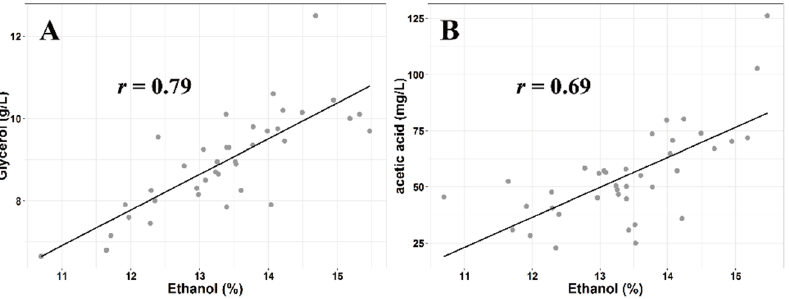
Figure 3. Correlation analysis between ethanol and glycerol ( A ) and acetic acid ( B ). For other fermentation aroma compounds, the Marselan wines from JDP and BHB contained relatively higher concentrations of isoamyl acetate, hexyl acetate, phenethyl acetate, octanoic acid, decanoic acid, ethyl decanoate, ethyl dodecanoate, isoamyl octanoate, 1-decanol, and 1-dodecanol (Table 2). Among these differentiated aroma compounds, the OAVs of isoamyl acetate (ranging from 21.1 in HZB to 55.0 in JDP), octanoic acid (ranging from 3.6 in HZB to 4.1 in JDP), decanoic acid (ranging from 2.3 in LP to 2.5 in JDP), and ethyl decanoate (ranging from 3.5 in LP to 7.4 in JDP) were greater than 1. These results indicated that Marselan wines from JDP and BHB regions may be charac- terized by a higher-intensity fresh fruity aroma. These volatile compounds are formed by the yeast metabolism from various precursors (mainly dominated by sugars, amino ac- ids, and fatty acids). Similar to acetic acid and glycerol, the differences of the fermenta- tion aroma compounds in wines among regions could also be affected by the differences of initial sugar in musts through yeast alcoholic fermentation. Furthermore, many studies comparing the naturally sweet wines made from dehydrated grapes with the corre- sponding base wines made from fresh grapes have concluded that the former contained higher concentrations of fatty acids, ethyl esters of fatty acids, and higher alcohol acetates [21,53,54]. Certainly, the formation mechanism of the volatile aroma compounds during alcoholic fermentation is complex. The initial concentrations of amino acids, fatty acids, and phenolic compounds in must could also affect the yeast metabolism during alcoholic fermentation [55]. However, how the matrix of grape must affects the volatile com- pounds of finished wine needs to be further studied. 3.4. Chromatic Parameters and Phenolic Compounds According to colorimetric measurements, Marselan wines from HZB, LP, and XJ re- gions displayed lower L values and higher values of a and C ab compared with the wines from JDP and BHB (Table 3). These differences may contribute to the relatively deeper color intensity and higher red-hue intensity in wines from HZB, LP, and XJ regions. No significant differences in b and H ab values existed among different wines.